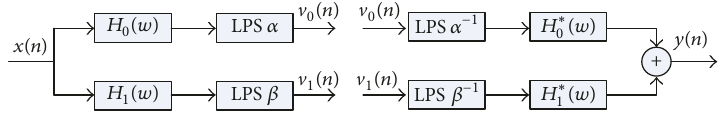
Figure 2: Analysis and synthesis filter banks for